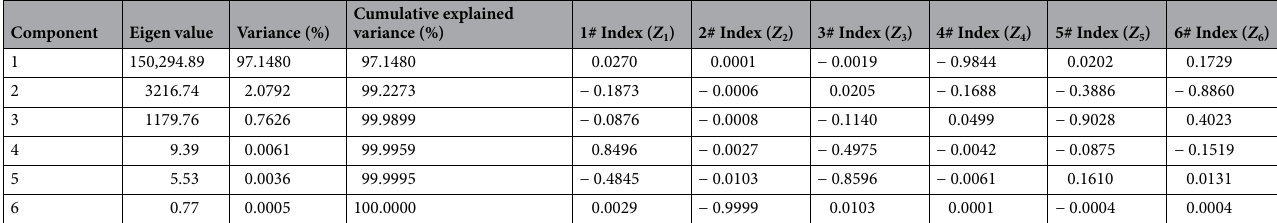
Table 5. Principal component analysis of six indexes and coefficients of the six principal components.